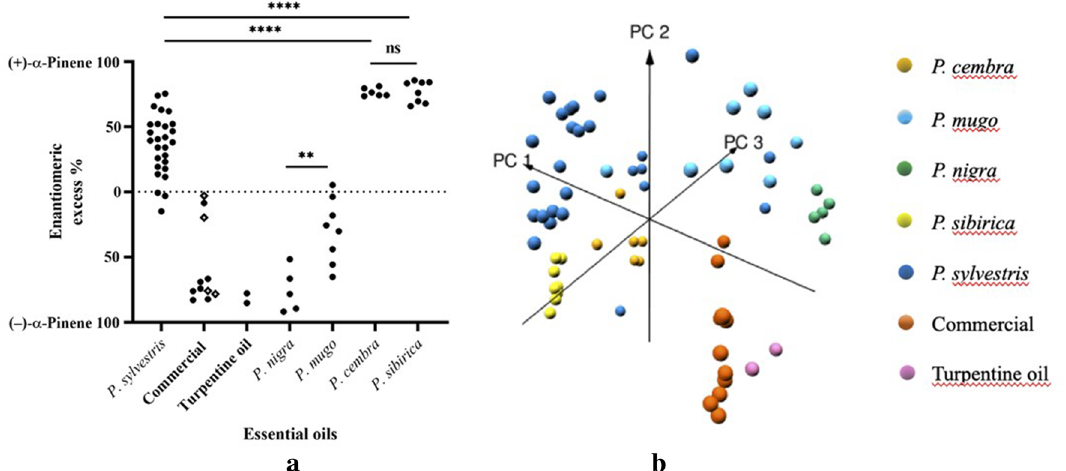
Figure 3. ( a ) The enantiomeric excess values (%) of (±)-α-pinene of primary, commercial pine EOs (ECHA products in diamond shape) and turpentine oil. Significance of the enantiomeric excess values (%) of (+)-α-pinene and (−)-α-pinene were tested using Welch’s ANOVA test followed by Games-Howell’s multiple comparisons post-hoc test with p < 0.01 (**), p < 0.0001 (****) and ns: not significant. ( b ) The 3D score plot of the first three principal components PC1 (45.5%), PC2 (15.2%) and PC3 (9.5%) for primary pine and commercial EOs based on their chemical composition obtained by the conventional GC-FID and ( ±)-α-pinene. EOs are colored based on their taxonomic specification and commercial origin,